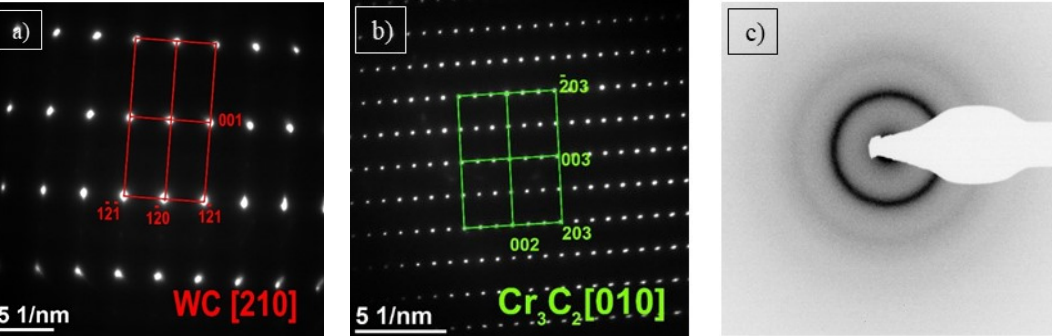
for the area marked as A ( b ) and B ( c ) and C ( d ).